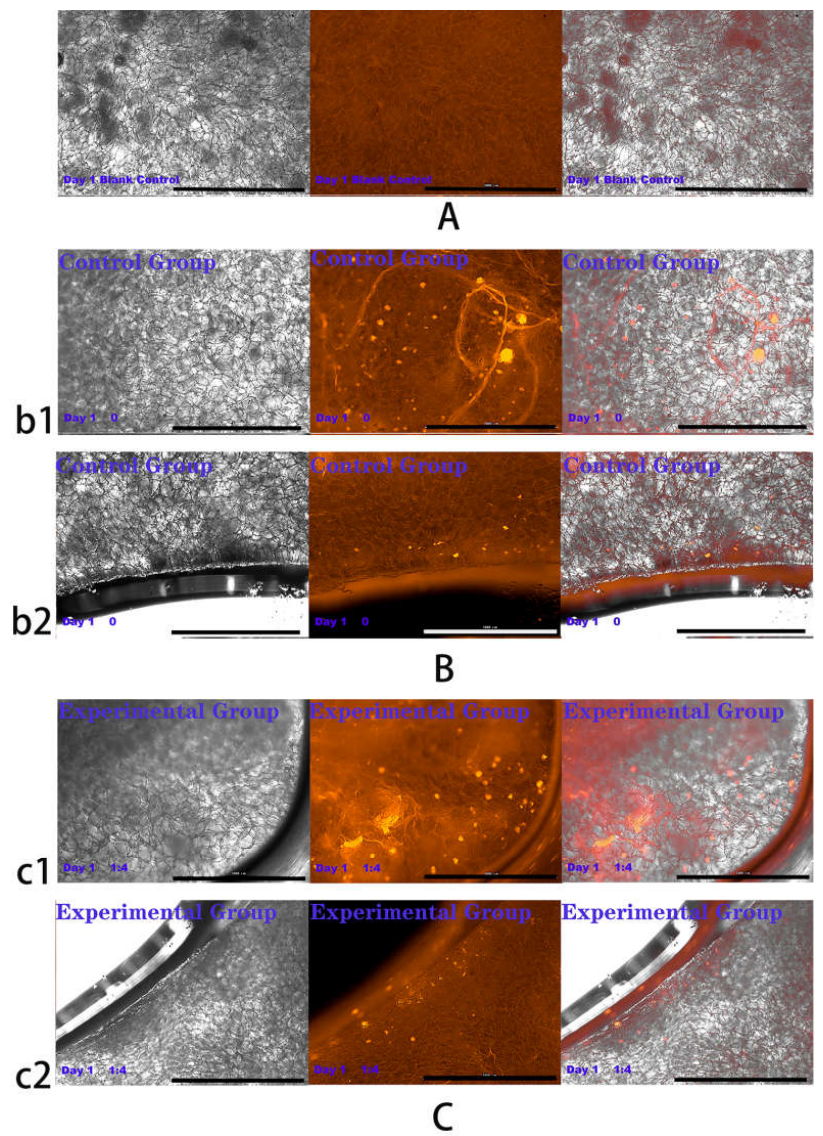
Figure 12. Cells were co-cultured for 1 day. Growth of HSFs labeled with amino graphene quantum dots on tissue engineering scaffolds. b1 and c1 are fluorescence maps of HSFs growing on the sur- face of tissue engineering scaffolds. b2 and c2 are fluorescence maps of HSFs growing on the cross section of the tissue engineering scaffolds. ( A ) Blank group, ( B ) control group, ( C ) experimental group. From left to right are the bright field diagram, the fluorescent field diagram, and the sum diagram of the bright field and the fluorescent field. Scale bar: 1000 μm.